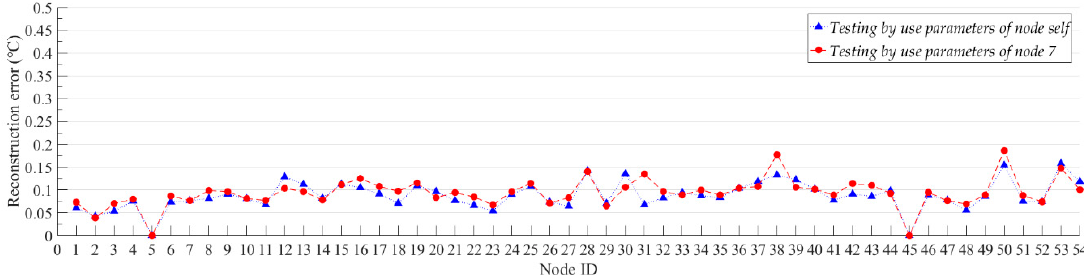
Figure 7. The average SNR values of models with different model parameters for all nodes. The blue box denotes the average SNR value of the model which testing by use the parameters of node self. The upper and lower boundaries of the blue box correspond to the plus or minus 1 dB range of the result value. The ‘ ’ symbol denotes the average SNR value of the model which testing by use the parameters of Node 7.